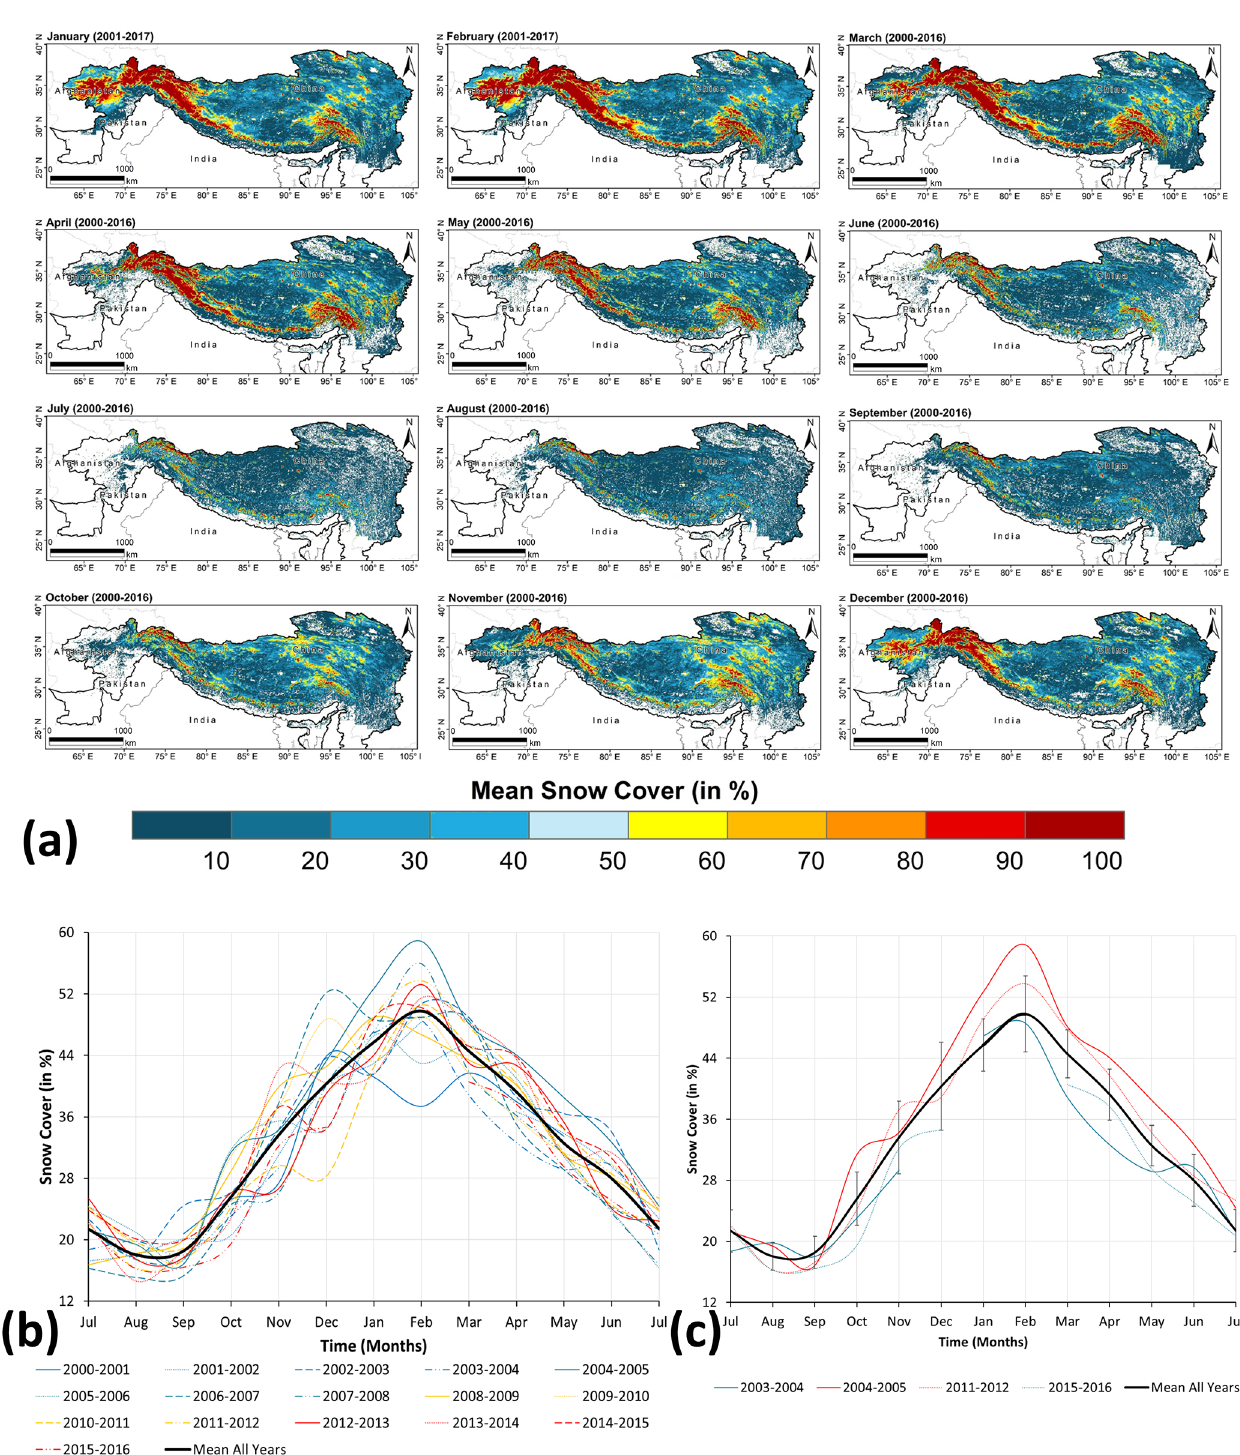
Figure 2. The monthly spatial distribution of MODIS-derived snow cover (in percent) over the HKH region during 2000–2017. (a) Monthly maps, (b) monthly variability over the years, and (c) monthly variability over the early phase (2003–2004 and 2004–2005) and later phase (2011–2012 and 2015–2016), compared to the average for the entire study period